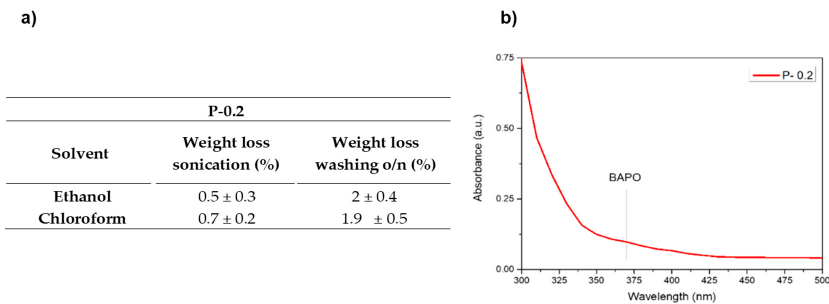
Figure 5. ( a ) Weight losses after the different washing steps in ethanol and chloroform for sample P- / n 0.2. ( b ) UV-Vis spectrum of the washing ethanol after the o/n step. ( b ) UV-Vis spectrum of the washing ethanol after the o